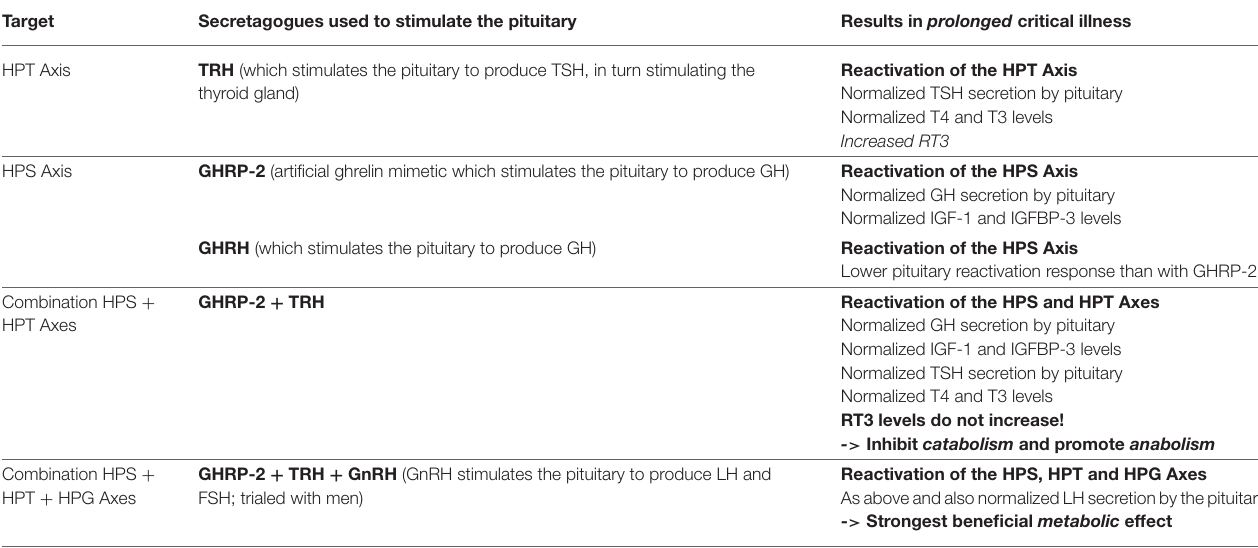
TABLE 1 | Summary of the treatment trials to reactivate the pituitary in prolonged critical illness as described by van den Berghe et al. (195, 196, 205, 206). Target